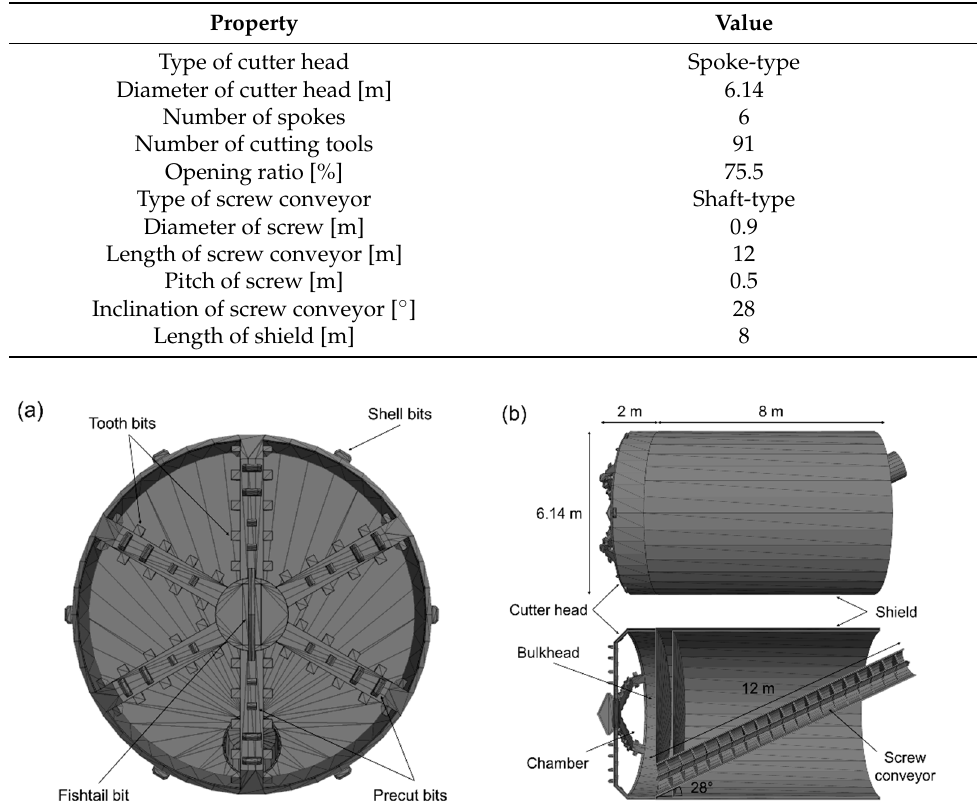
Figure 3. Configuration of EPB shield model consisting of wall elements for numerical simulation: ( a ) front view; ( b ) side and sectional views.